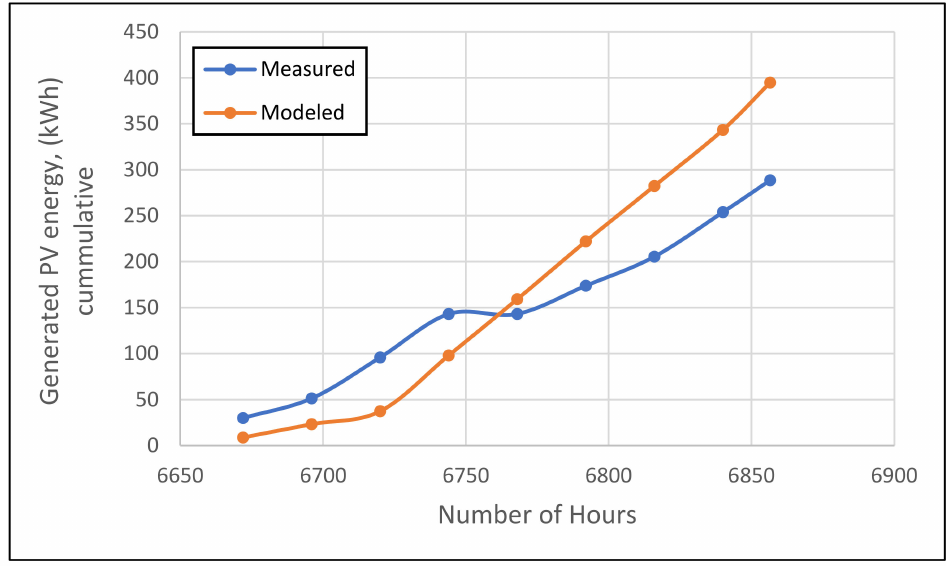
Figure 11. The cumulative PV electricity as modeled and generated.